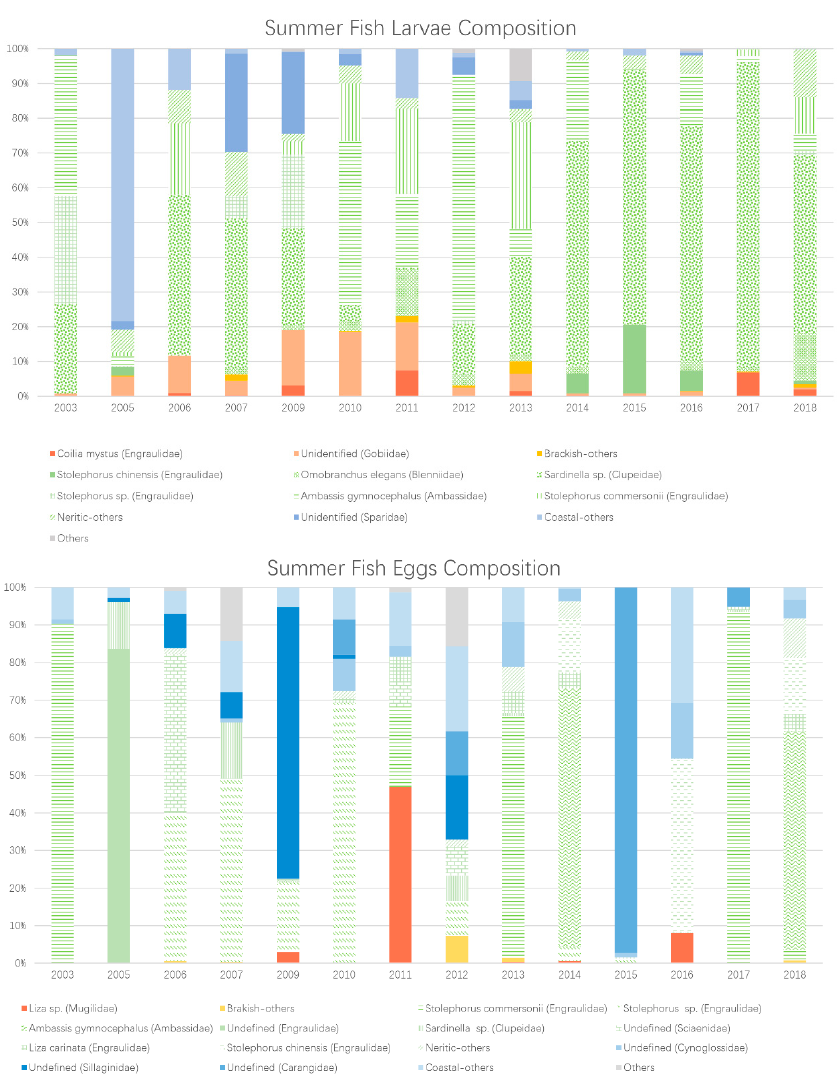
Figure 4. Circle: mean abundance distribution of the fish larvae and eggs in the PRE. Colors: partitions among the brackish, neritic, and coastal species of fish larvae and eggs in the PRE. The light blue represents the contour lines of the corresponding mean surface salinity field.